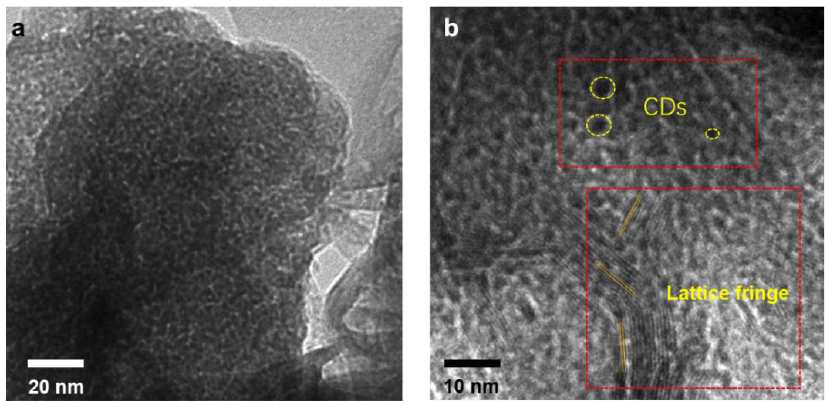
Figure 4. ( a ) TEM image and ( b ) HRTEM image of porous carbon dots/TiO 2 . The insert yellow circles indicate the incorporated CDs and the yellow stripes indicate the lattice fringe of (101) plane of the anatase TiO 2 .